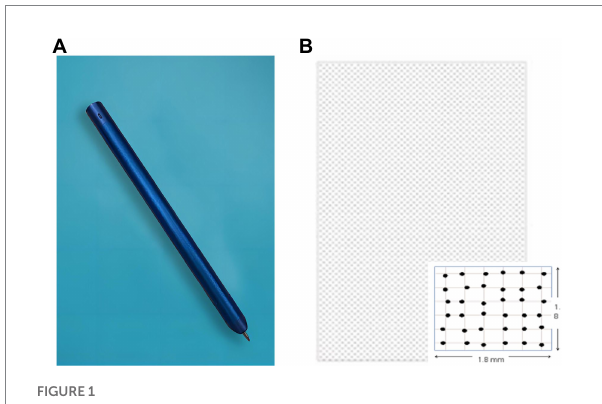
FIGURE 1 (A) Dot-matrix pen diagram; (B) Dot-matrix paper diagram.